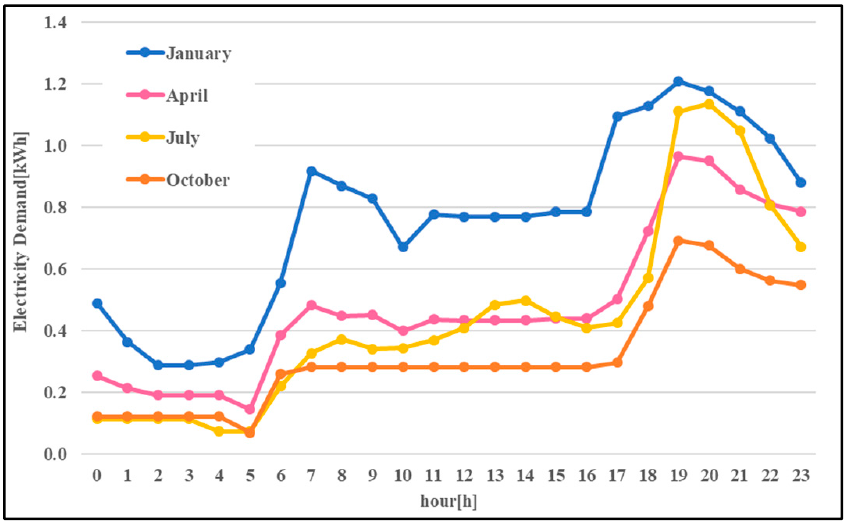
Figure 6. Electricity demand for a typical Japanese household.